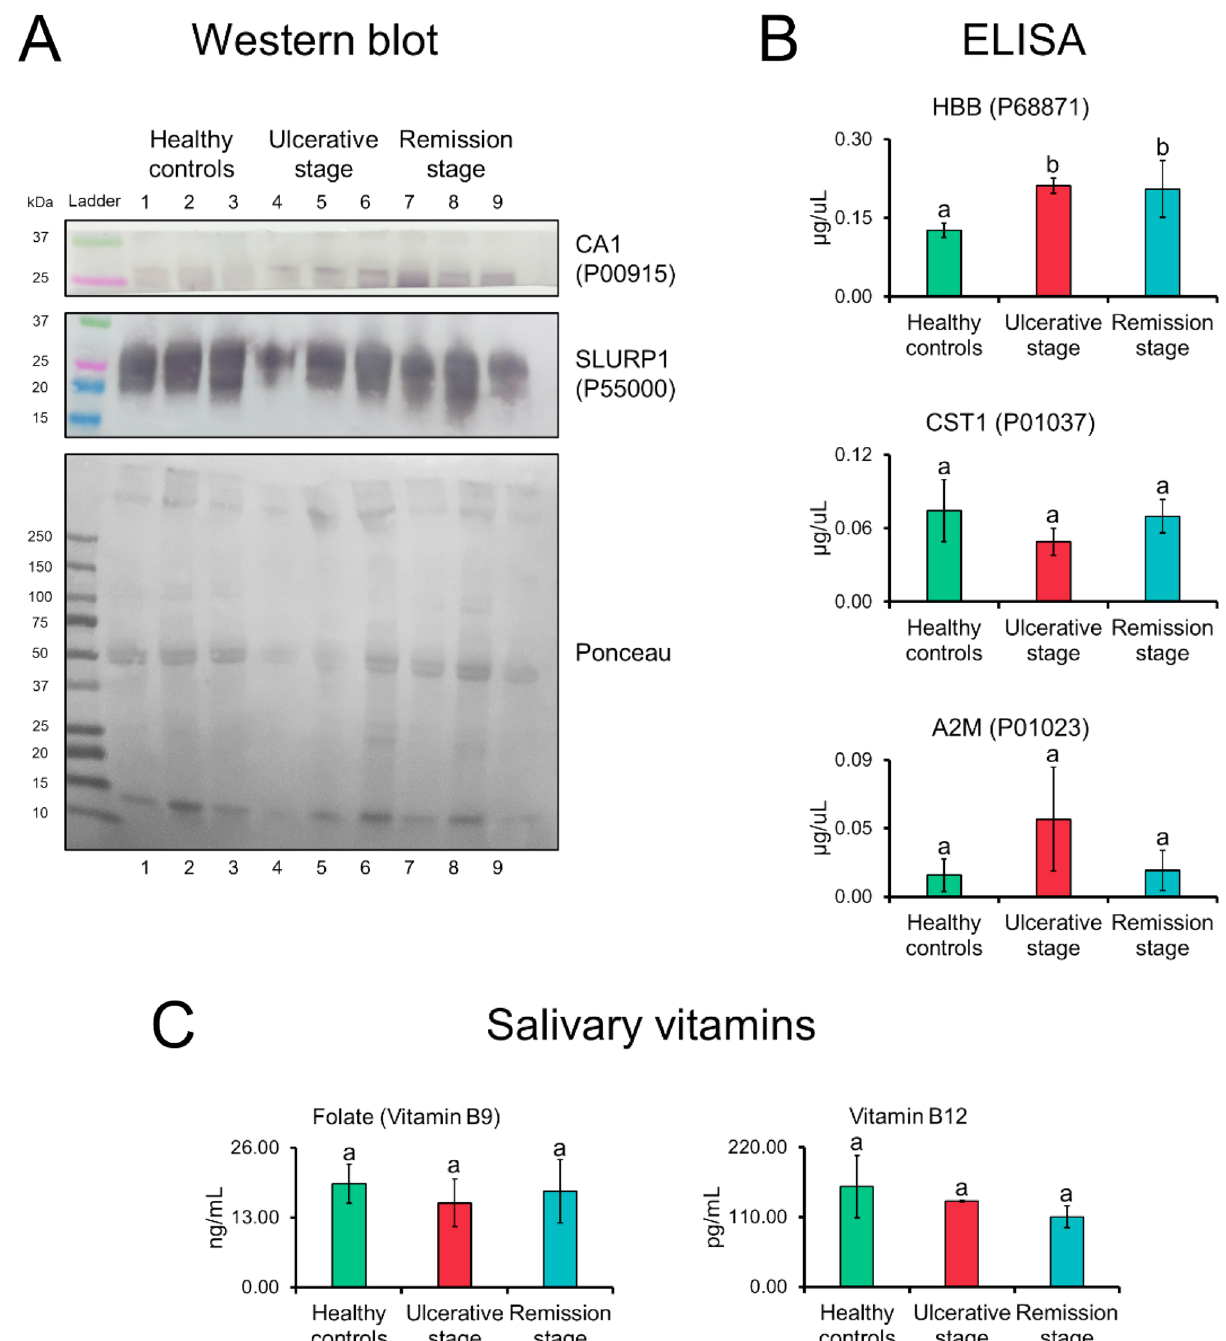
Figure 4. Salivary proteins and vitamins during the clinical course of recurrent aphthous stomatitis. Verification of proteomic data points. ( A ) Western blotting showed higher CA1 protein levels during the ulcerative and remission stages. Ponceau red were used as loading control. ( B ) ELISA showed a higher amount of HBB protein in ulcerative and remission stages. ( C ) Samples from patients with recurrent aphthous stomatitis show lower levels of folate (vitamin B9) and vitamin B12, but without statistically significant differences. Data are represented by mean ± SD (Student’s t-test, different letters indicate statistically difference at p value ≤ 0.05). CA1, carbonic anhydrase 1; SLURP1, secreted Ly-6/uPAR-related protein 1; HBB, hemoglobin subunit beta; CST1, cystatin-SN; A2M,